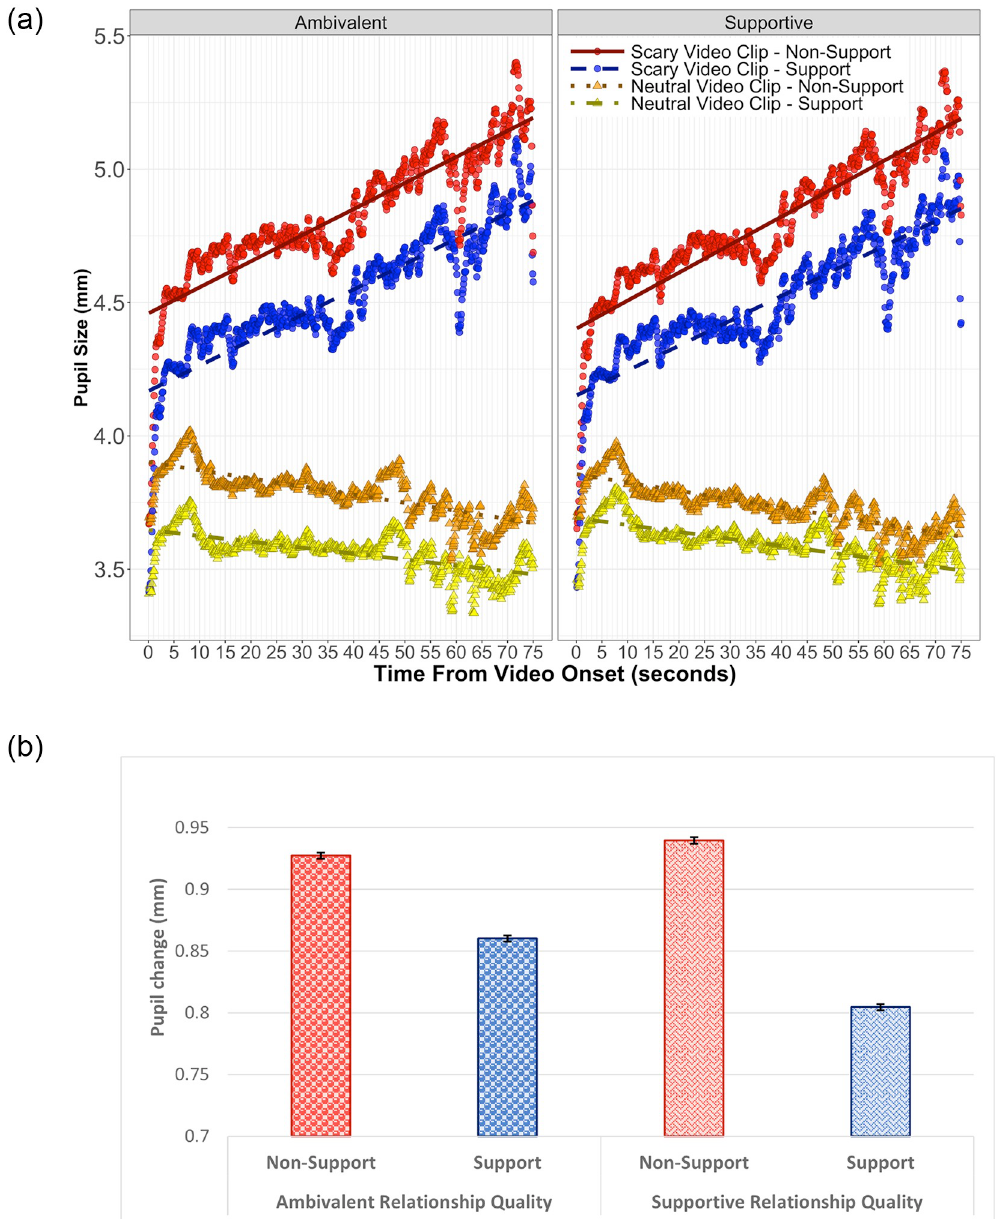
Fig 3. a: Tonic pupil size as a function of video condition , spouse condition , and relationship quality . Note . Graph shows pupil size in millimeters across all video clips from videos’ onset to videos’ end. The lines depict the average linear change for all participants and for all video clips as reported in Table 4. Circles and triangles represent the raw data in 100ms bins. b: Average tonic pupil change by condition : Three-way interaction . Note . This graph depicts the amount of increase in pupil size by condition when viewing the horror videos compared to pupil size during neutral videos. Having a supportive marital relationship while concurrently having one’s spouse hold their hand resulted in less pupil dilation during horror videos. Graph depicts the same data as Fig 2a but modeled as change scores to represent more clearly this statistically significant three-way